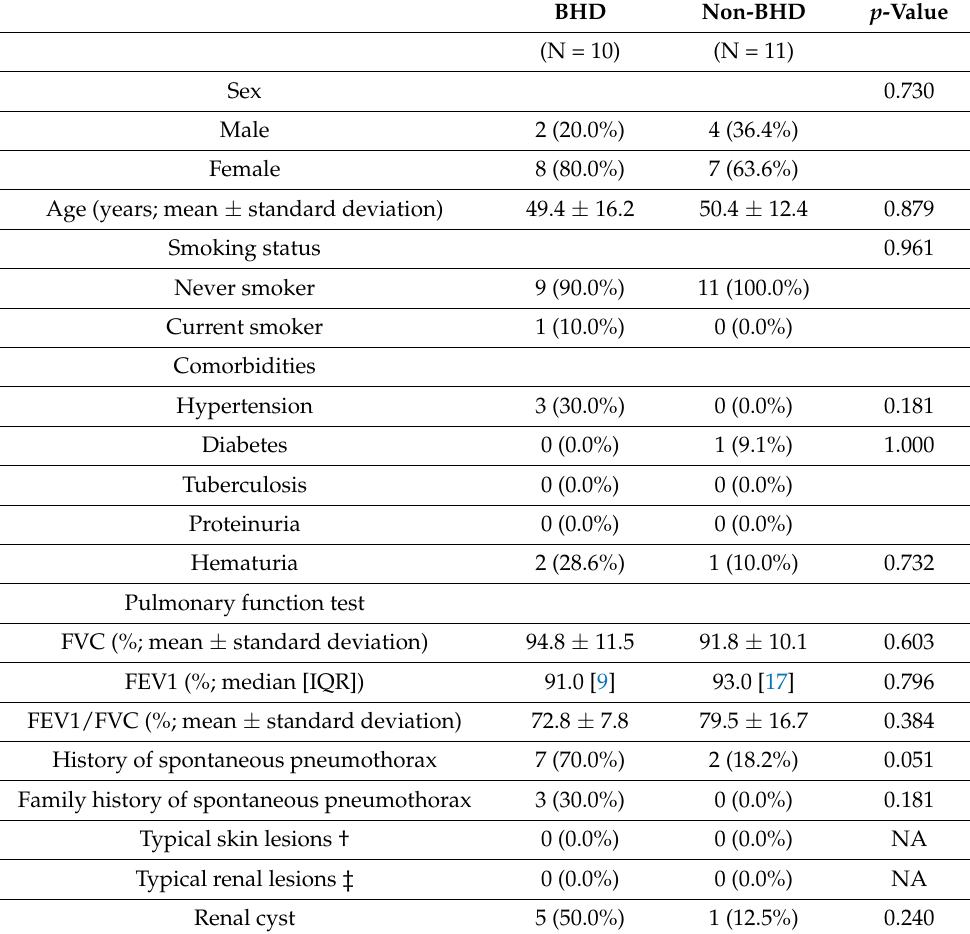
Table 1. Baseline characteristics of patients according to the results of screening for FLCN gene